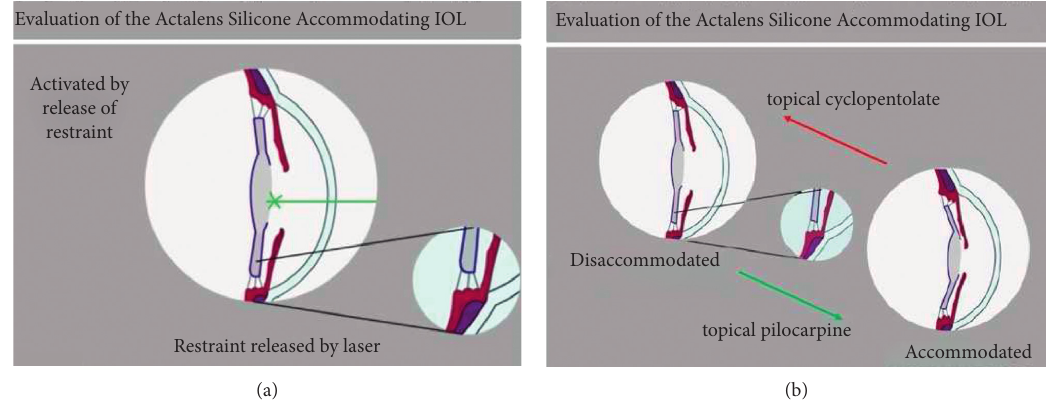
Figure 1: Drawing of the principle of the investigated IOL. Suture lysis (a) and effect of pilocarpine and cyclopentolate